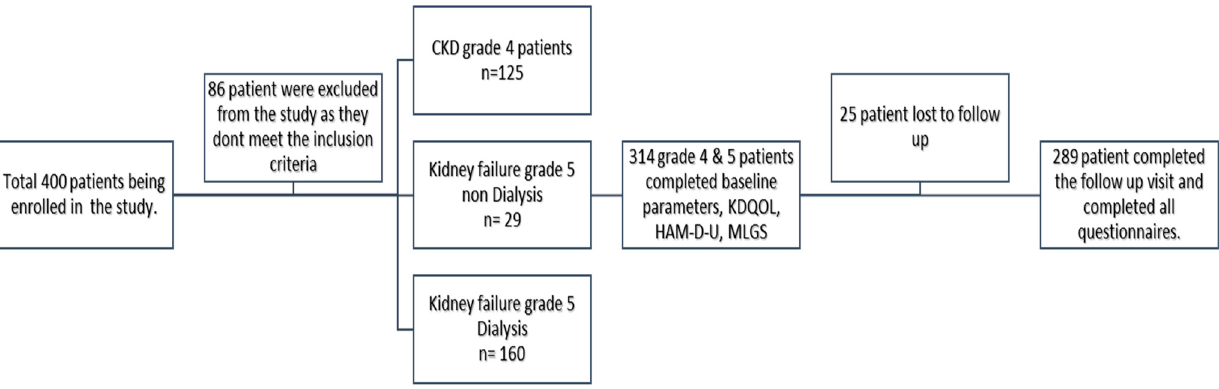
Figure 2. Schematic representation of patient enrollment and data collection.